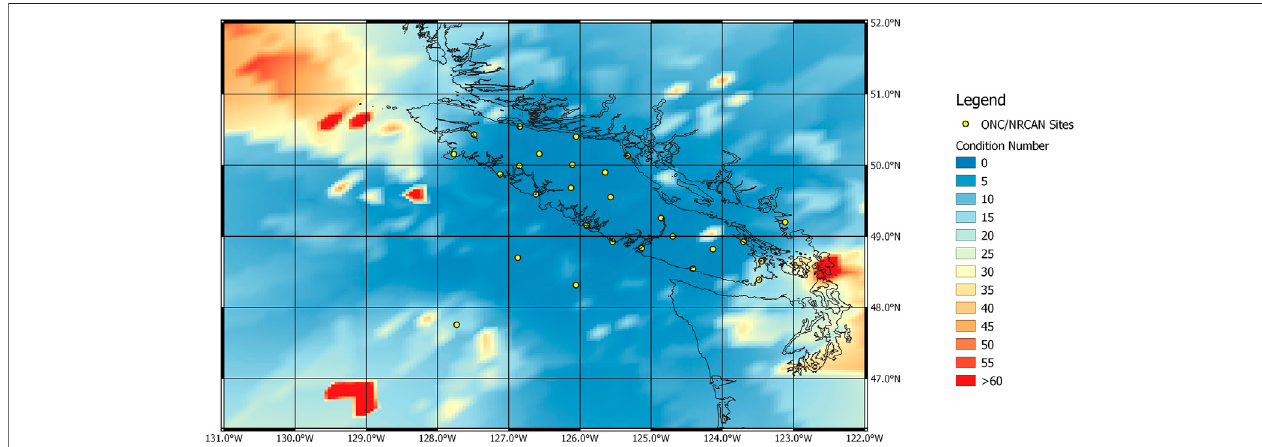
FIGURE 6 | Results from the LLS algorithm for the fi rst ten stations that detected an event located anywhere in the geographic region. Condition numbers greater than 30 are connected predominately to regions where the relative base-line of the respective 10 station array is short. Yellow circles mark the location of the seismic stations that were included in the modelling approach.